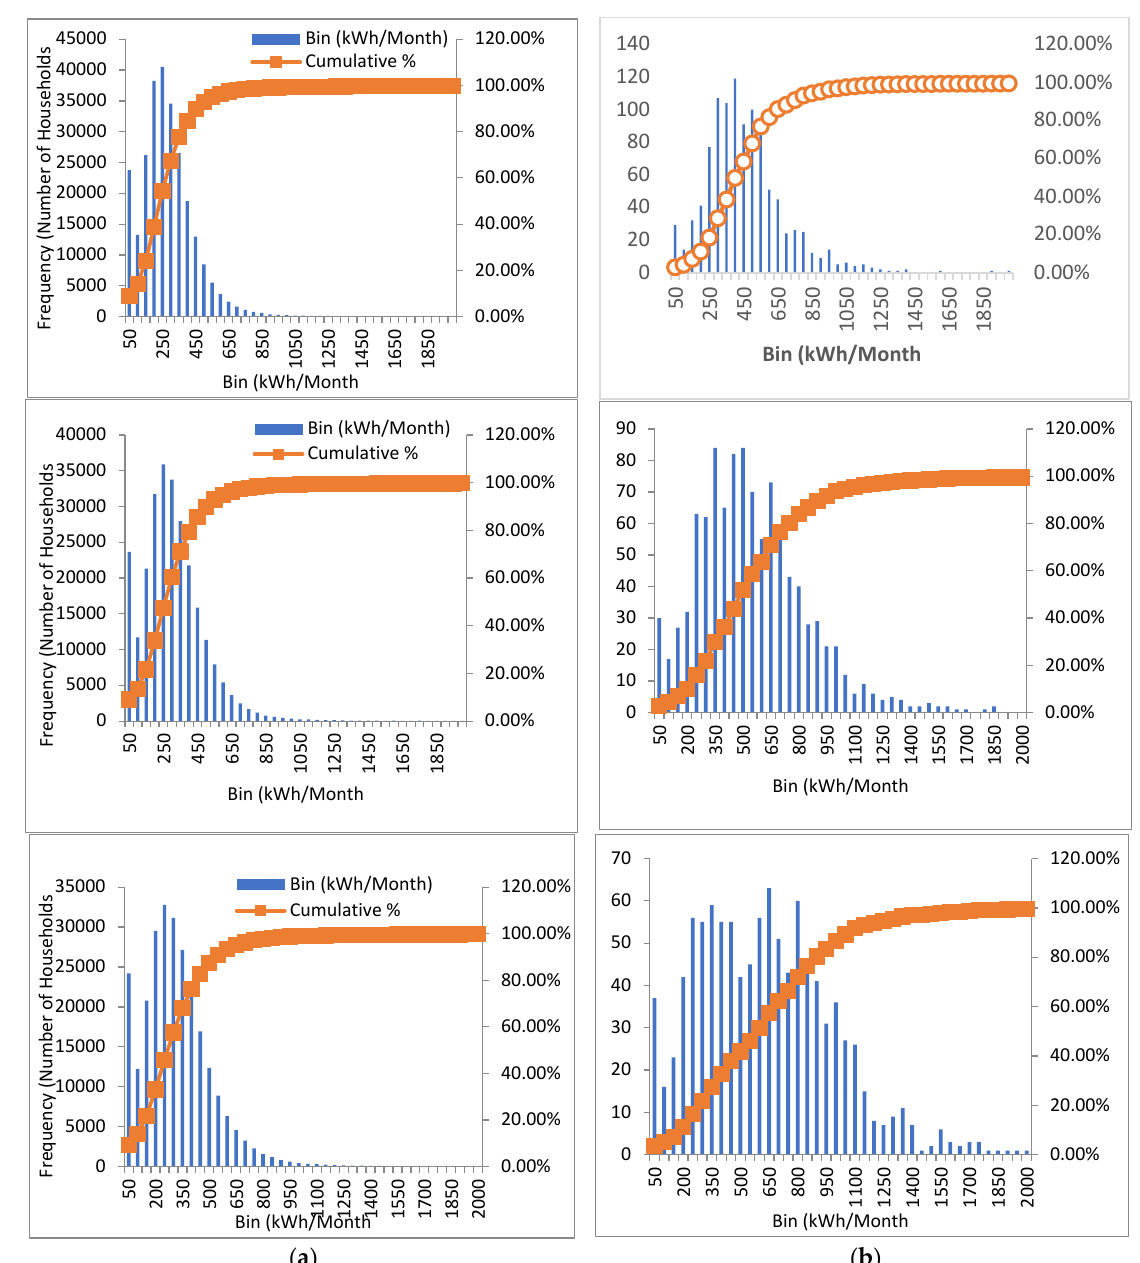
Figure 10. Energy consumption June, July, August, and September: ( a ) Ordinary households; and ( b ) Subsidized households.